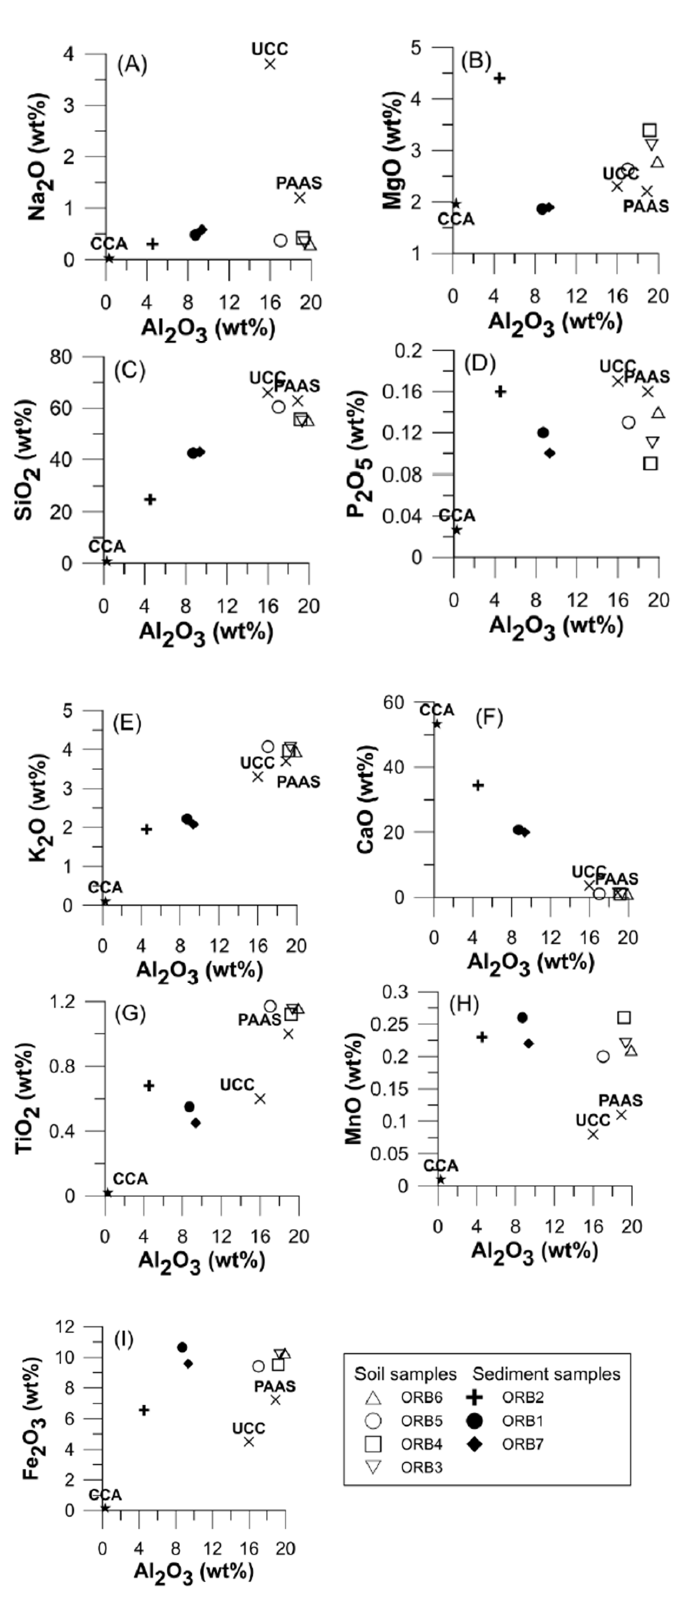
Figure 10. Variation diagrams of major elements of sediment (black symbols) and soil samples (open symbols) plotted against Al 2 O 3 : ( A ) Na 2 O vs. Al 2 O 3 ; ( B ) MgO vs. Al 2 O 3 ; ( C ) SiO 2 vs. Al 2 O 3 ; ( D ) P 2 O 5 vs. Al 2 O 3 ; ( E ) K 2 O vs. Al 2 O 3 ; ( F ) CaO vs. Al 2 O 3 ; ( G ) TiO 2 vs. Al 2 O 3 ; ( H ) MnO vs Al 2 O 3 ; ( I ) Fe 2 O 3 vs Al 2 O 3 . Composition of major elements of UCC, Post Archean Australian Shale (PAAS) and the Calcare Cavernoso (CCA) of the Ansedonia area are shown for